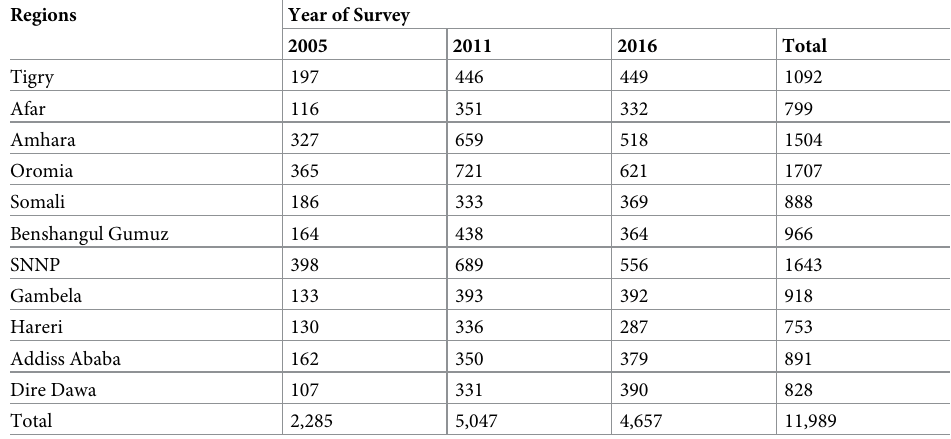
SNNP: South Nation Nationality and Peoples